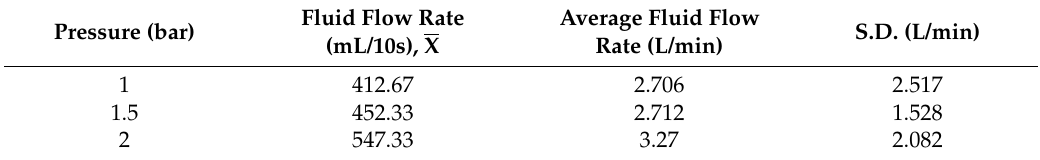
Table 2. Chemical spraying rate testing.